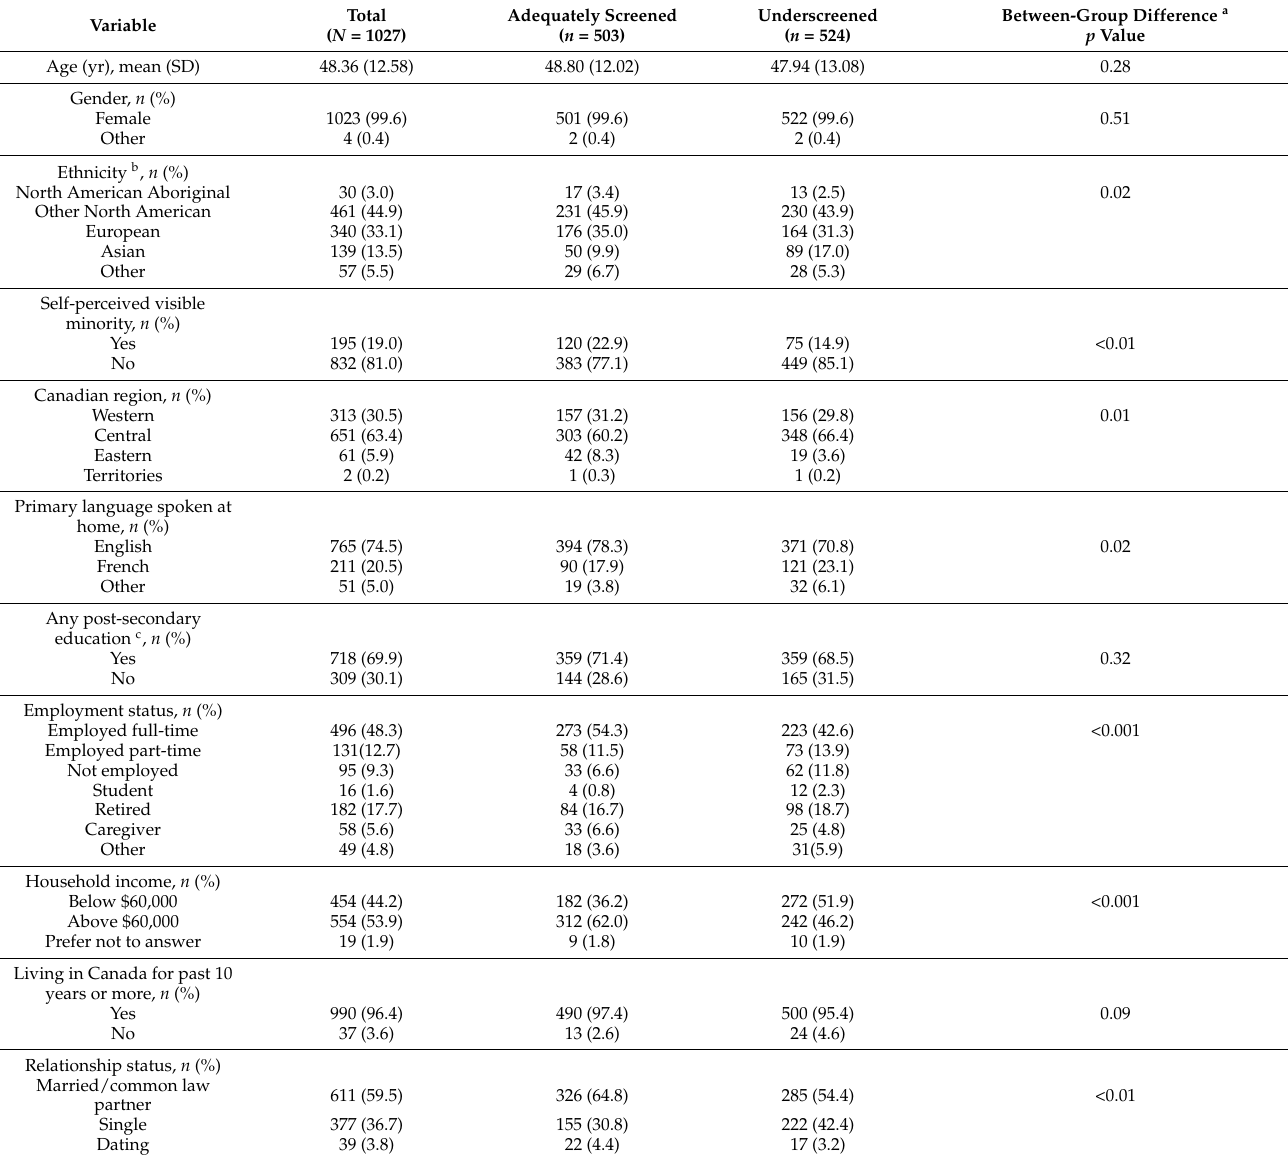
Table 1. Sample Characteristics ( N =